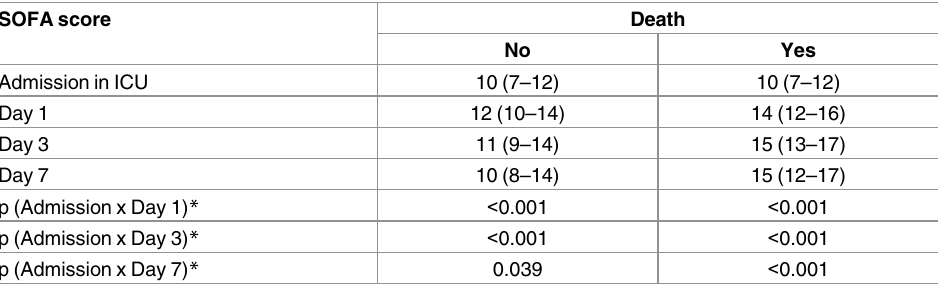
Table 4. Comparisons of SOFA values in relation to